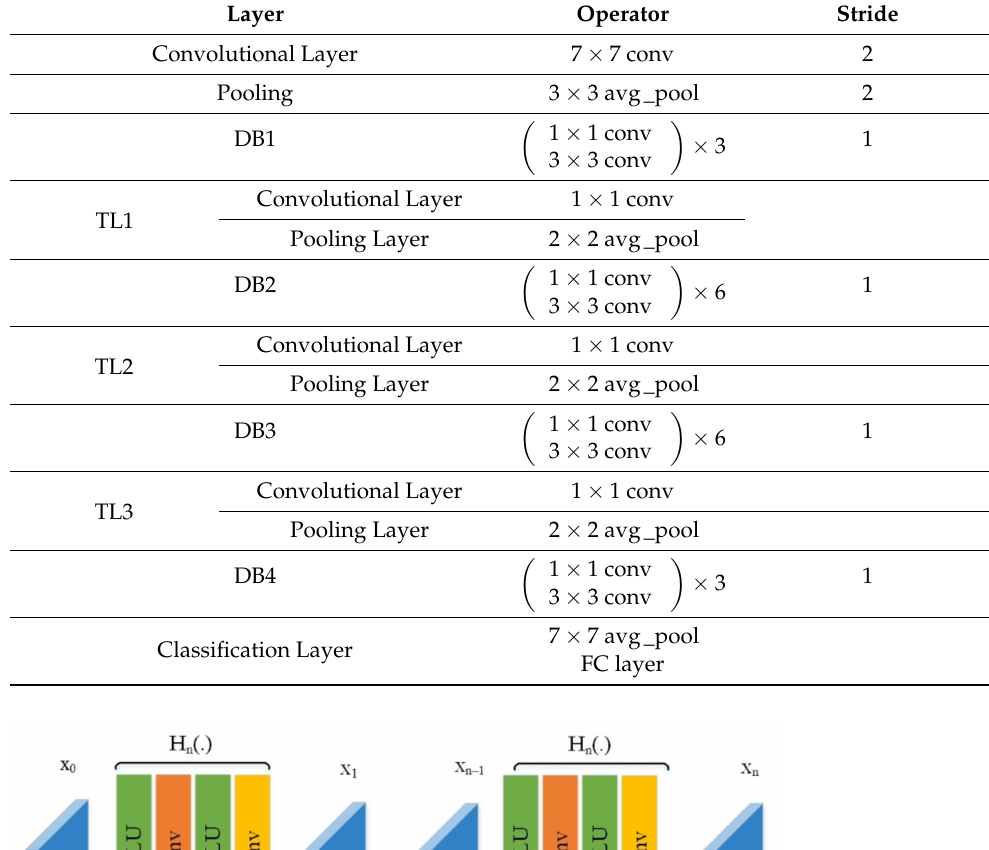
Table 2. Architecture of DenseNet-41.